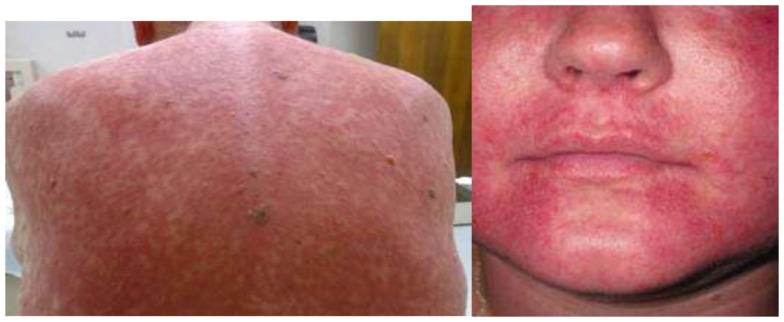
“Red man” syndrome.